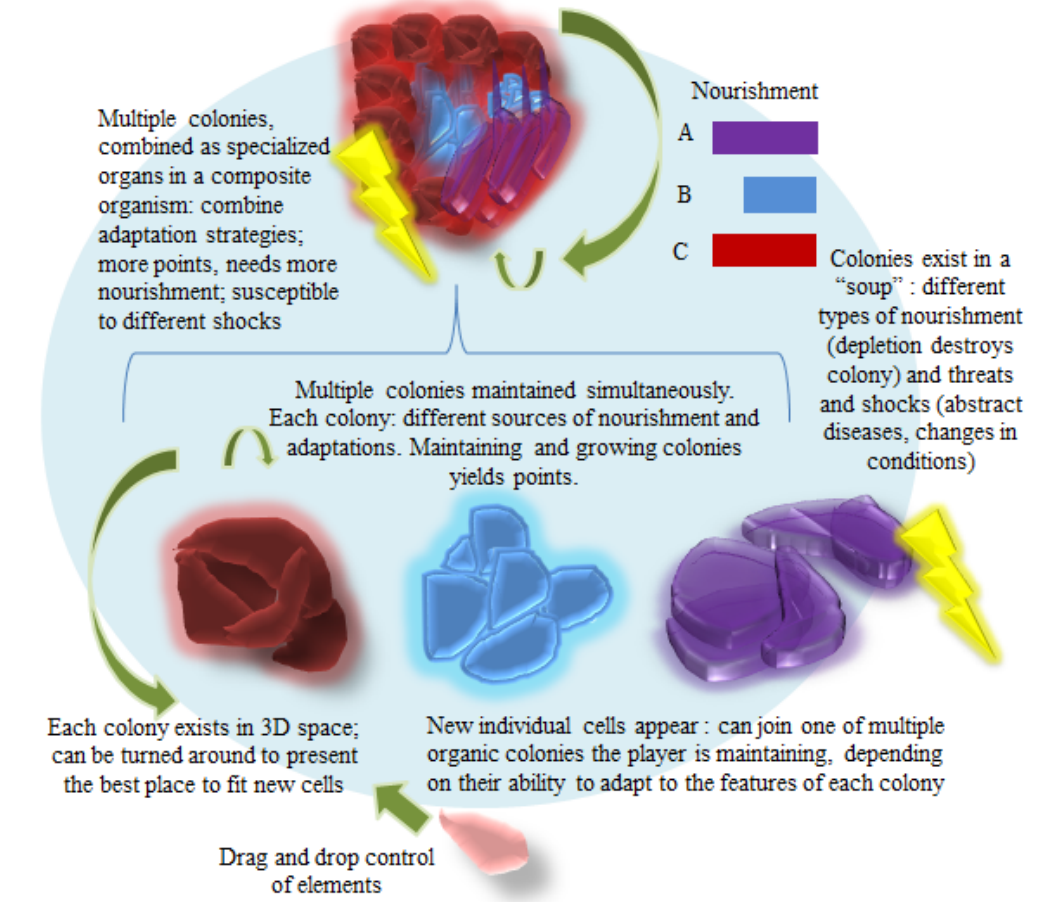
Fig. 1 . Organismus, showing the conceptual versions of the colony and organism levels in the game space. Suspended in a contextual “soup,” players can manipulate 3D cells that, if similar enough, can be assembled into colonies with specific adaptations to the context and nourishment requirements. The maintenance and growth of colonies yields points. Multiple colonies can be maintained, and, if compatible, combined as organs of a greater organism. This organism has more diverse strategies for nourishment and adaptation to its context, but also requires more and more diverse resources, while yielding more points. The context of colonies and organisms changes dynamically, bringing up more challenges and opportunities for growth and combination. There is no end point to the